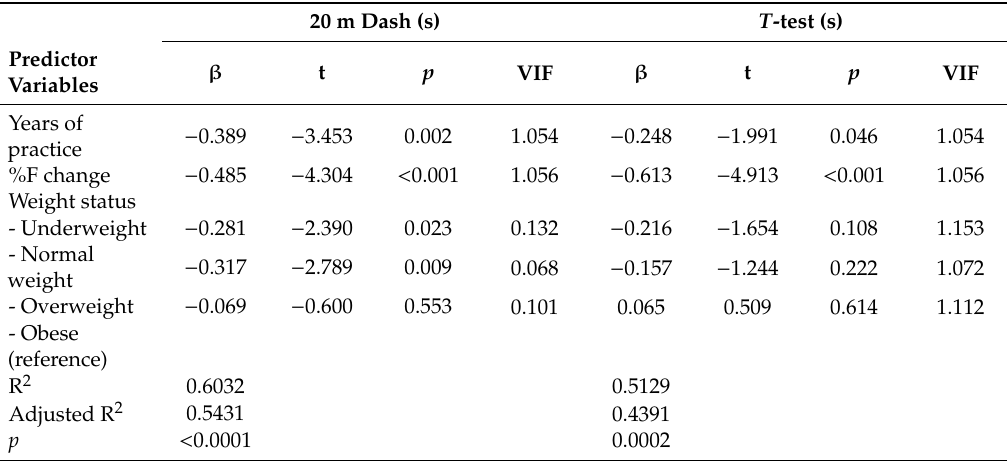
Table 3. Predictors of 20 m dash test and T -test: results of multivariate regression